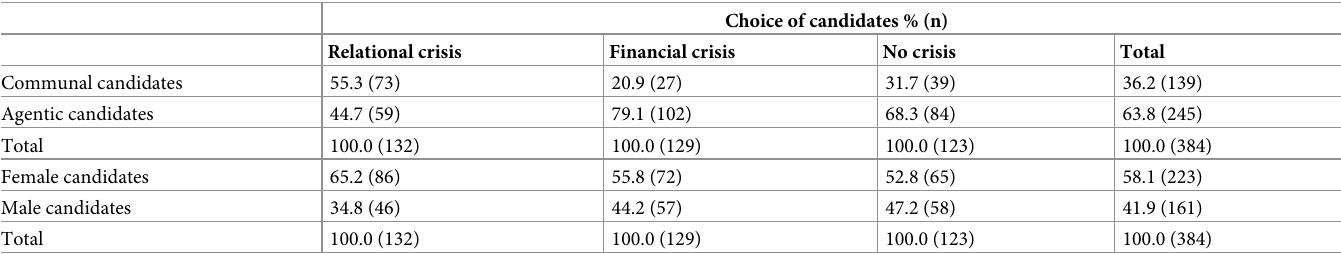
Table 2. Choice of a communal versus agentic and female versus male CEO as a function of type of crisis (Study 2, United States of